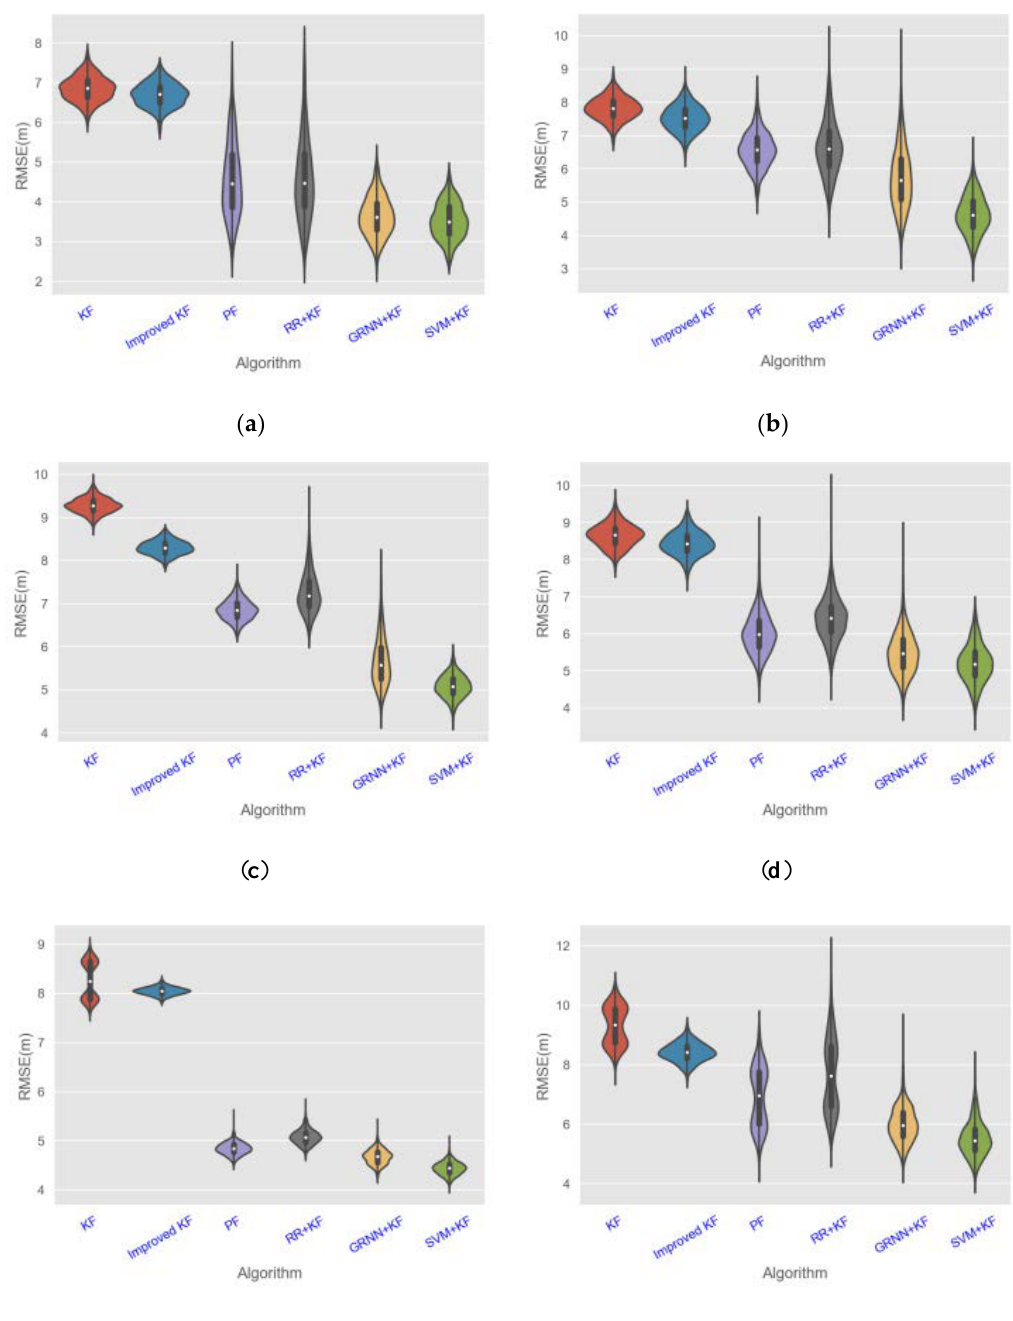
Figure 6. Violin diagram of simulation results of different algorithms with 100 rounds. a , c , and e are the simulation results of motion trail 1, 2, and 3 in the constant velocity (CV) motion model, respectively, and b , d , and f are the simulation results of motion trail 1, 2, and 3 in the constant acceleration (CA) motion model, respectively.